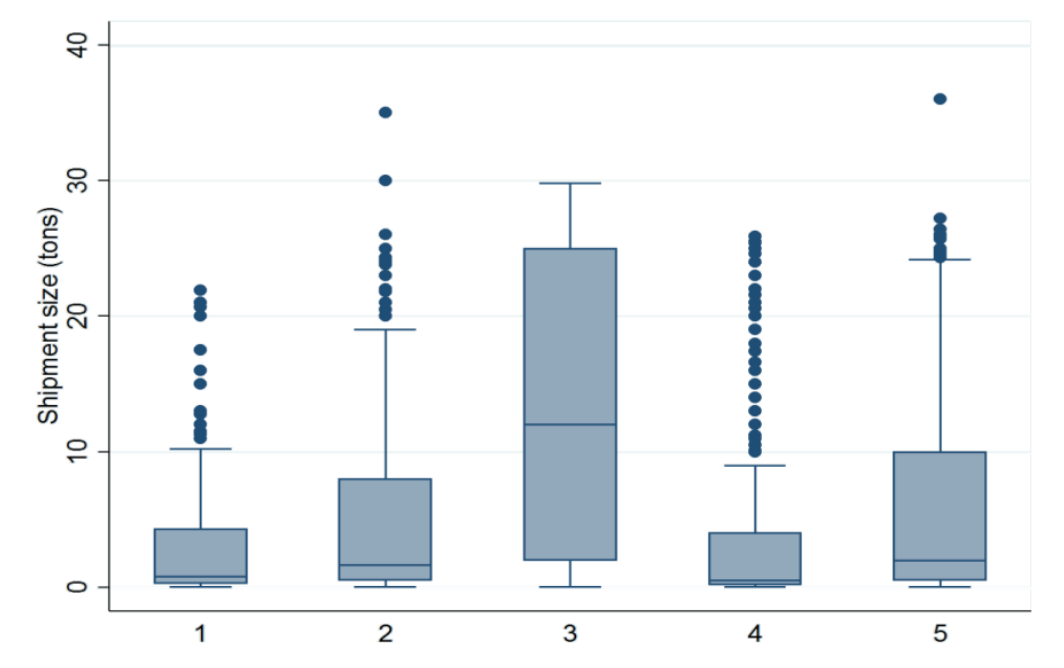
Figure 2: Boxplots of shipment sizes for derived